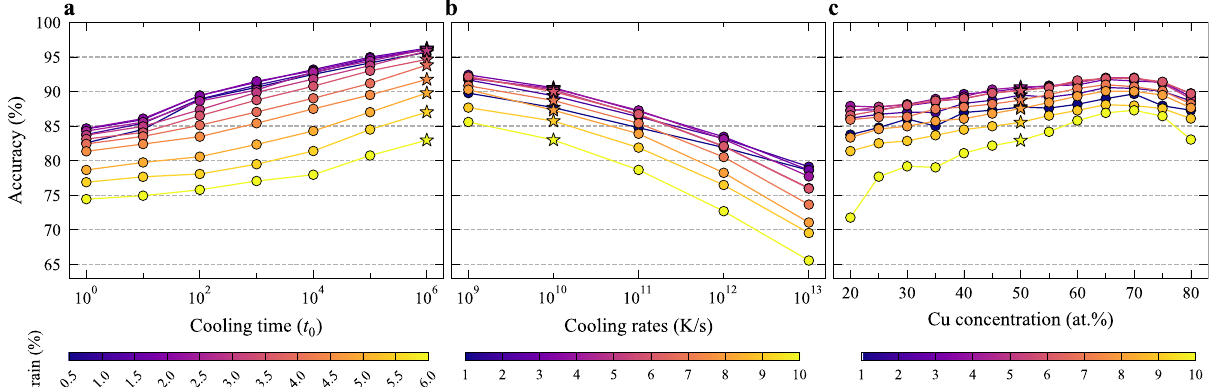
Fig. 5 The ability of CNN models to generalize. The CNN models were trained on samples at a single composition with one processing history (the 2D ffiffiffi p (cid:1) (cid:3) : 4, quenched within 10 6 t 10 K/s). The accuracy of the glasses at the composition of N L : N S = 1 þ 5 0 . The 3D Cu 50 Zr 50 glasses were quenched at 10 models is shown in a for 2D glasses quenched with different cooling times, in b for Cu 50 Zr 50 glasses quenched with different cooling rates, and in c for Cu x Zr 100- x glasses of different compositions quenched at a constant effective cooling rate of 10 10 K/s. In the plots, the stars are for the training condition and circles for non-training conditions.